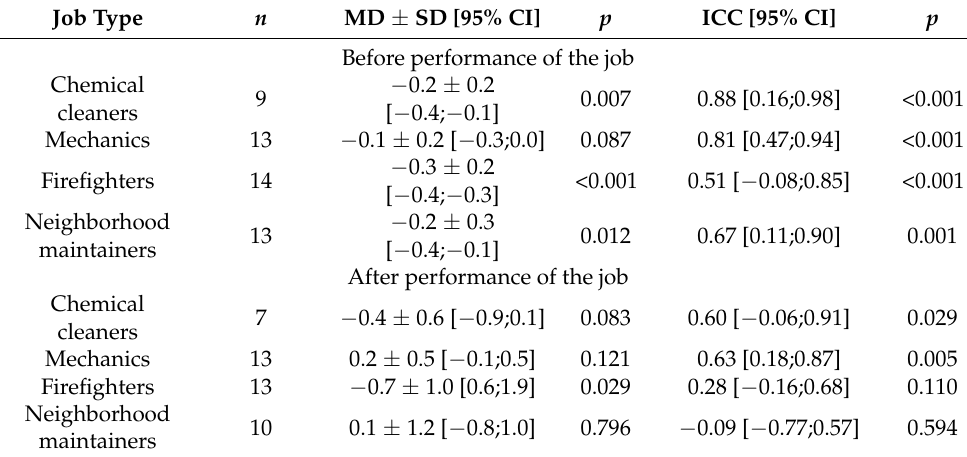
Table 5. Cosinuss ◦ corrected per subject. The Cosinuss ◦ was compared with the ear canal IR thermometer per company using the intraclass correlation coefficient (ICC) with a confidence interval of 95% and p